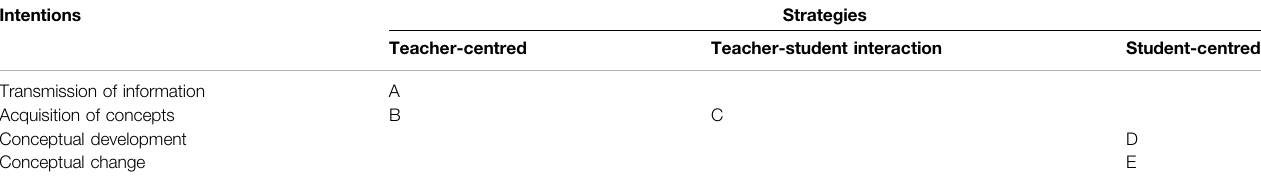
TABLE 1 | Intentions and strategies of teaching